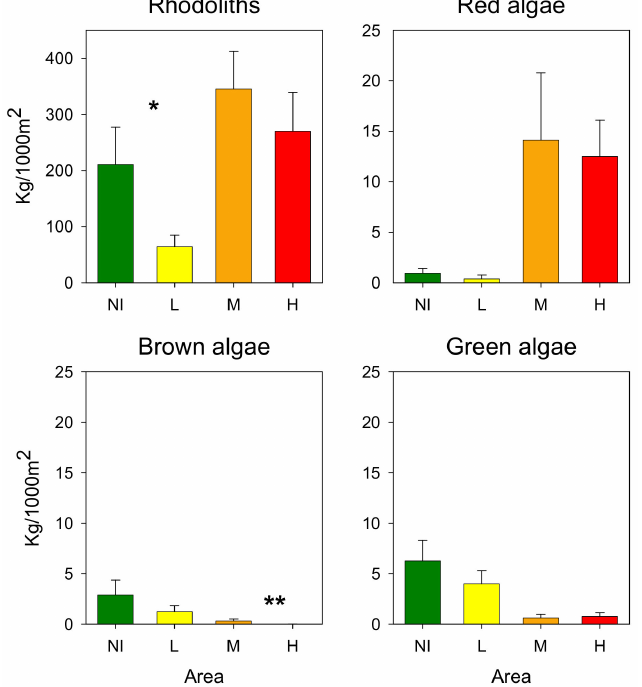
Figure 5. Mean values and standard errors of biomass (kg/1000 m 2 ) for the main groups of algae, estimated from beam trawl samples in the four areas considered: Non-impacted (NI), Low effort history (L), Medium effort history (M), and High effort (H). Red algae are Rhodophytes not included in rhodoliths. p -values of the Student’s t -test to test for differences between areas are presented: * p < 0.05; ** p < 0.01; *** p <